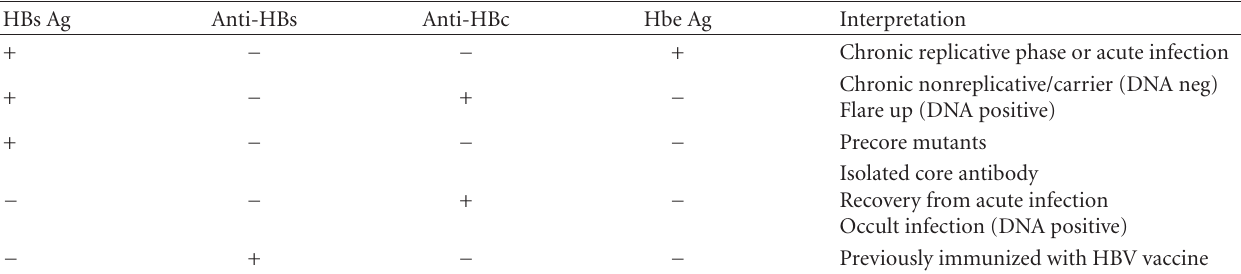
Table 1: Findings and interpretations of HBV serologic